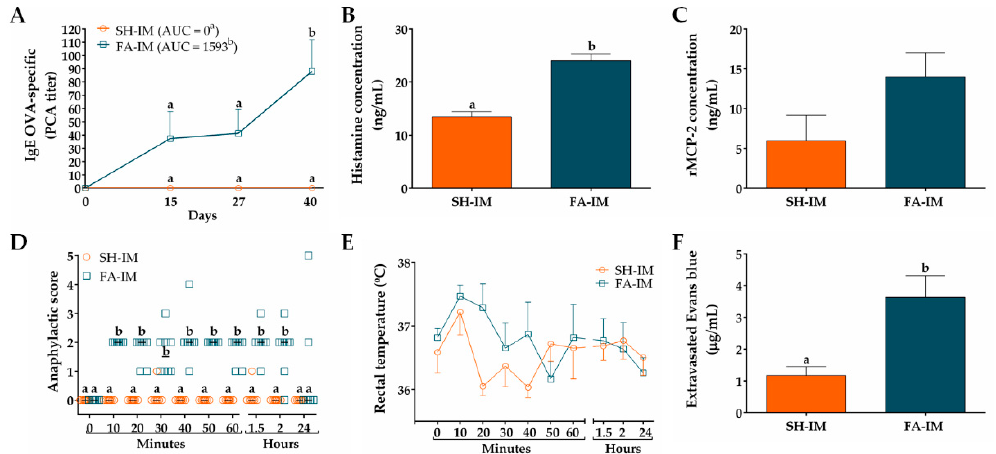
Figure 3. Characteristics of IgE-mediated food allergy (FA) induced by systemic allergen sensitization. ( A ) IgE OVA-specific titers in serum at different times measured by passive cutaneous anaphylaxis (PCA) reaction and represented as the inverse of the titer ( n = 6); the values of area under the curve (AUC) were evaluated. Concentration of ( B ) histamine and ( C ) rat mast cell protease (rMCP)-2 in serum 30 and 120 min after OVA challenge at days 27 and 40, respectively ( n = 3). Food anaphylaxis evaluated by ( D ) signs score and ( E ) rectal temperature of animals after the final allergen challenge at day 40 ( n = 6). ( F ) Intestinal edema of rats after the final allergen challenge analyzed by intestinal extravasated Evans blue ( n = 4, in triplicate). SH-IM, sham control of intramuscular sensitization and oral challenge; FA-IM, FA-induced by intramuscular sensitization and oral challenge. Different letters (a,b) indicate statistical difference.